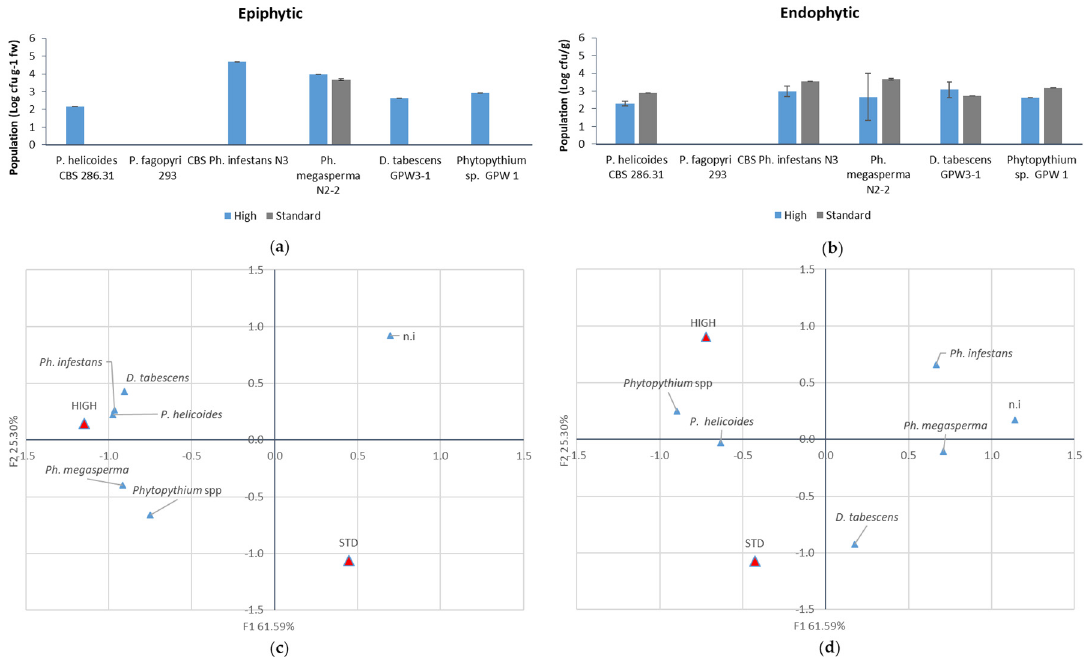
Figure 6. Incidence of epiphytic ( a ) and endophytic ( b ) colonisation expressed as percentage of positive samples (%) in high irrigation (HIGH) input standard strategies (STD) after experimental inoculation. Two-dimensional principal component analysis (PCA) describing the distribution of samples based on water input (HIGH or STD) and the re-isolated populations on the surface ( c ) or inside ( d ) kiwifruit roots.